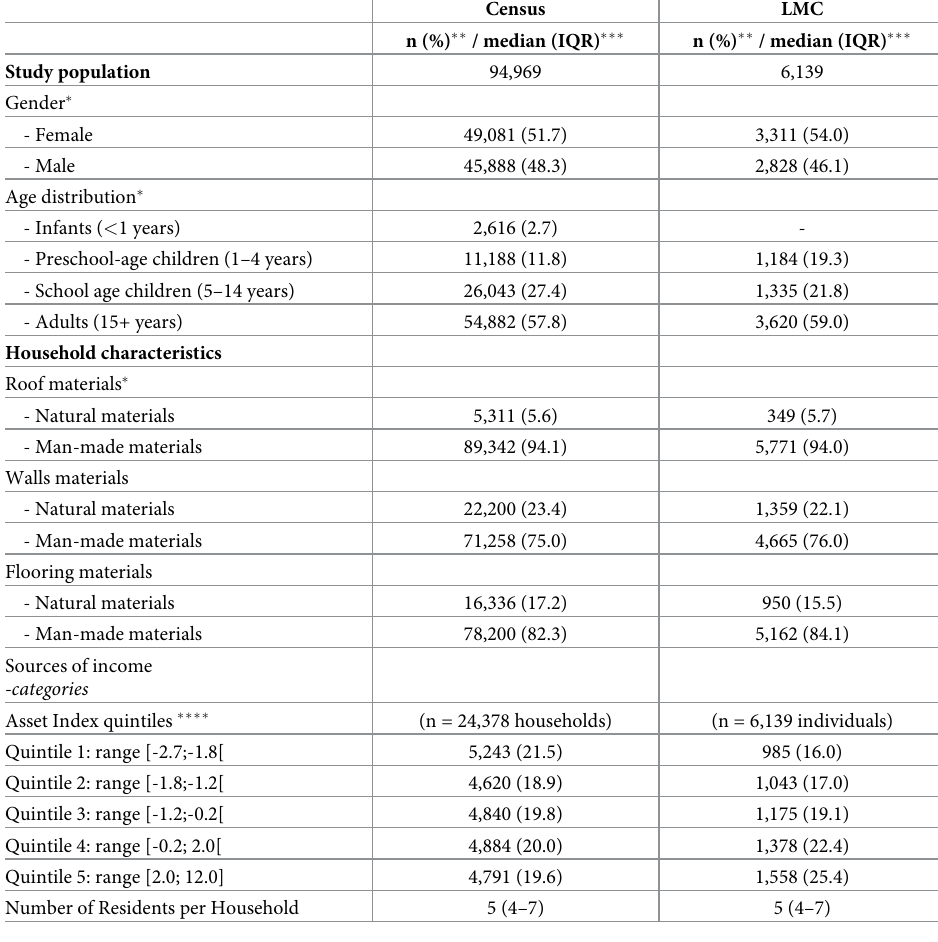
Table 1. Comparison of censused population of the DeWorm3 site and longitudinal monitoring cohort